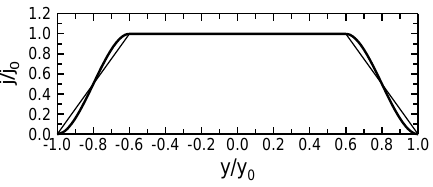
Figure 6. Profiles of the surface current density j along a sheet. The thick line is a profile which is smooth; that is, it has zero derivatives at ± y 1 and ± y 0 ( y 1 = 0 . 6 y 0 in the plot). The thinner line is the trapezoidal profile used in the current paper (cf. Fig. 2) and it is shown for a